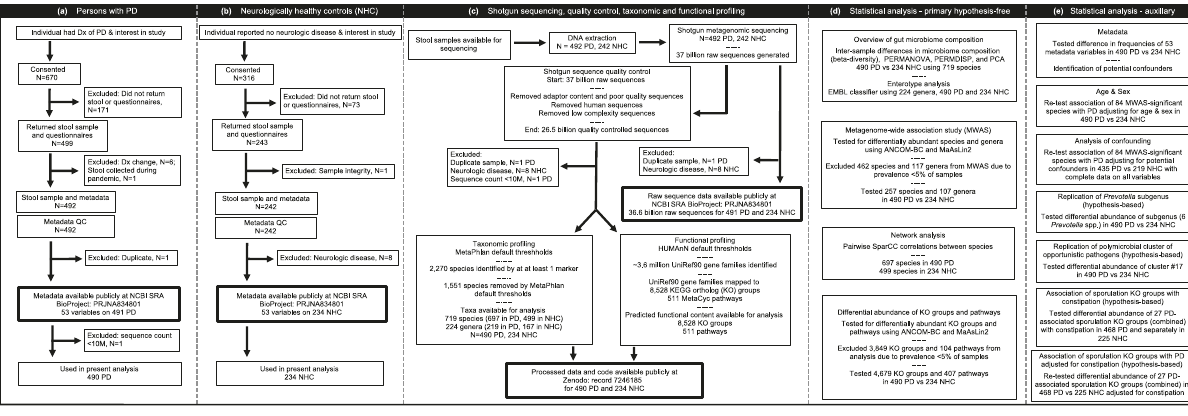
Fig. 1 | The STORMS fl owchart. Following reporting guidelines for human microbiome research 23 , we show the step-by-step process by which the study was conducted, starting with subject selection, enrollment and data collection for